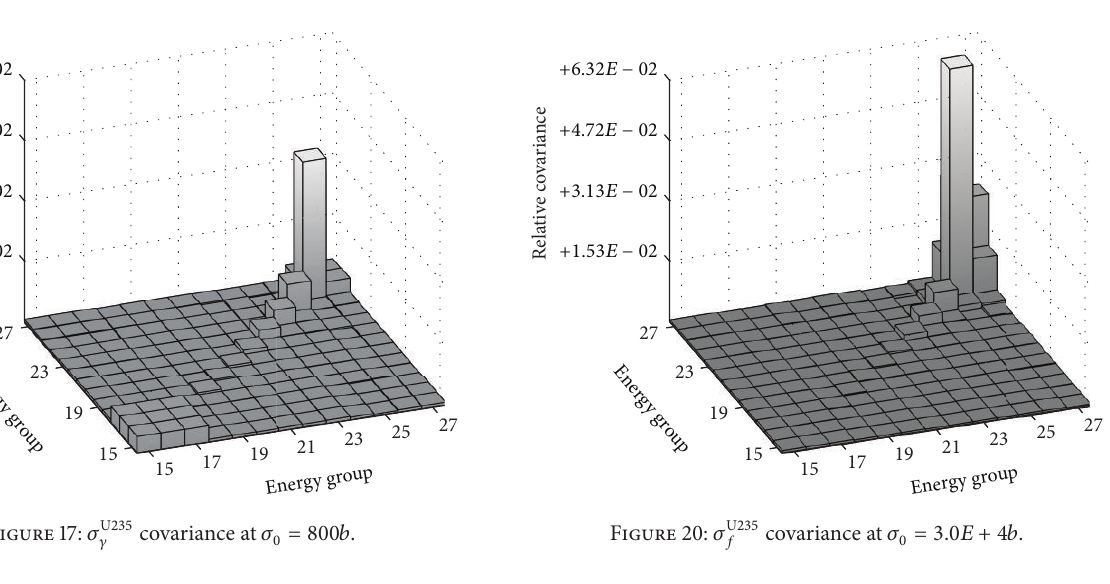
Figure 16: 𝜎 U 235 𝛾 covariance at 𝜎 0 = 3.0𝐸 + 4𝑏 .